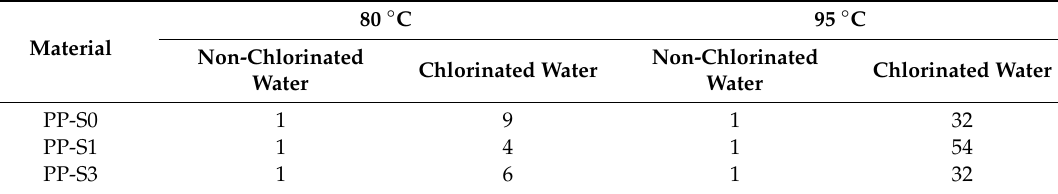
Table 2. Deterioration factors for the crack growth rate at ∆ K = 0.3 MPa · m 0.5 for the three materials investigated at 80 ◦ C and 95 ◦ C in non-chlorinated and chlorinated